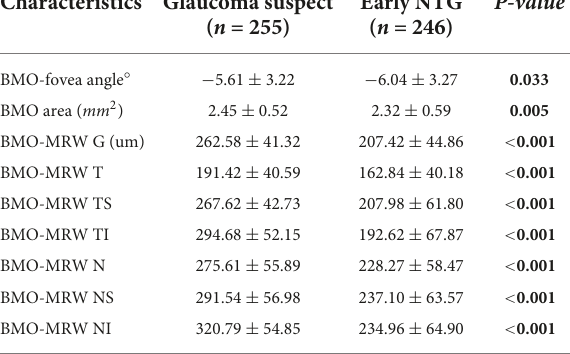
and 255 GS were obtained by cropping the center images from BMO Overview, as shown in Figure 2A . The dataset TABLE 2 Brunch membrane opening minimum rim width of glaucoma suspect and early normal-tension glaucoma subjects. Characteristics Glaucoma suspect ( n = 255)